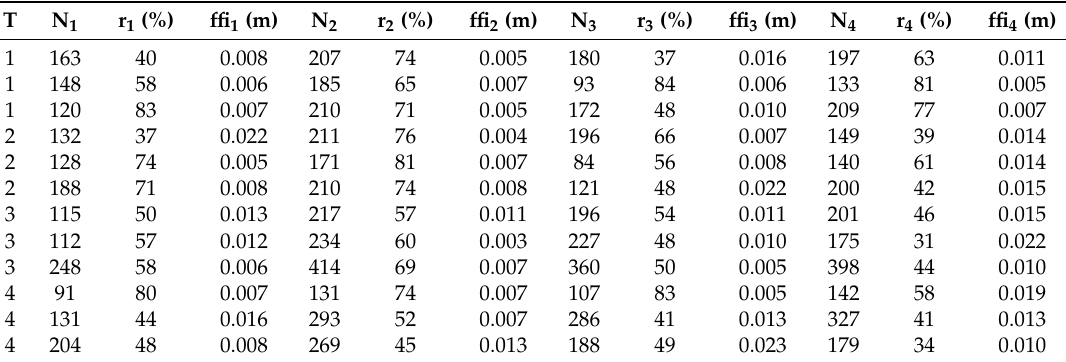
Table 4. Fitting residual of four principal legs.